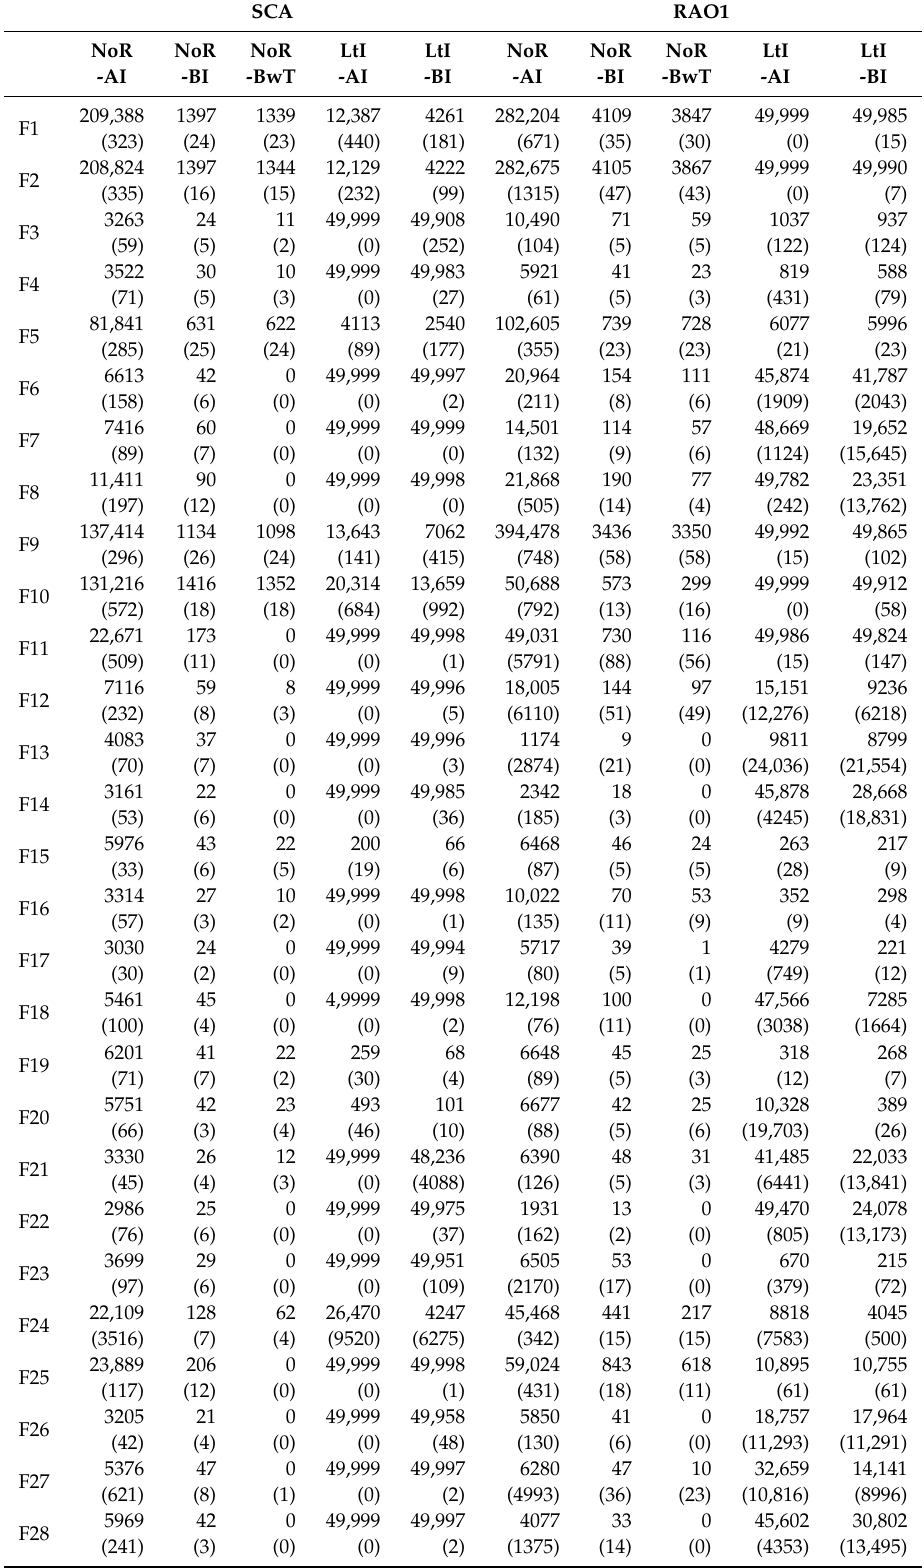
Table 4. Analysis of sine cosine algorithm (SCA) and Rao’s optimization Algorithm 1 (RAO1) on function F1-F28 with a population size of